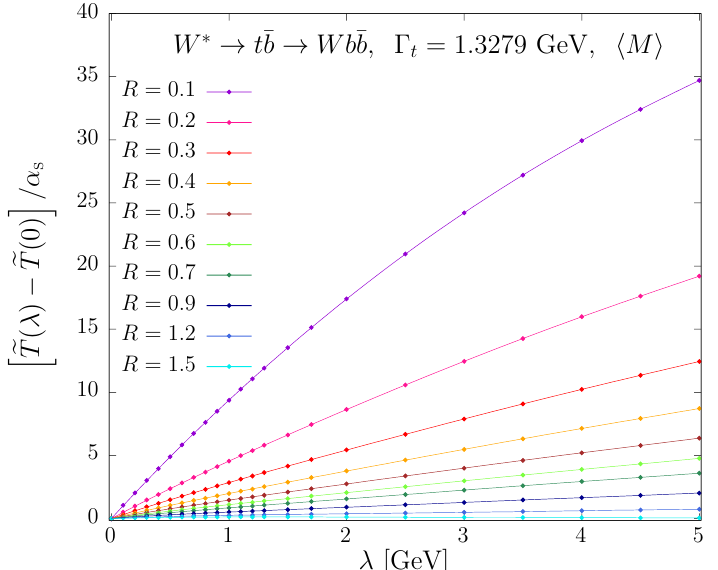
Figure 8 . Small (cid:21) behaviour of e T ( (cid:21) ) for the averaged reconstructed-top mass, for several values of the jet radius R . The solid lines represent the polynomial (cid:12)t of the computed points. For R (cid:21) 1 : 2 a 4 th order polynomial is adopted, while for the other R values a 5 th order polynomial is employed.